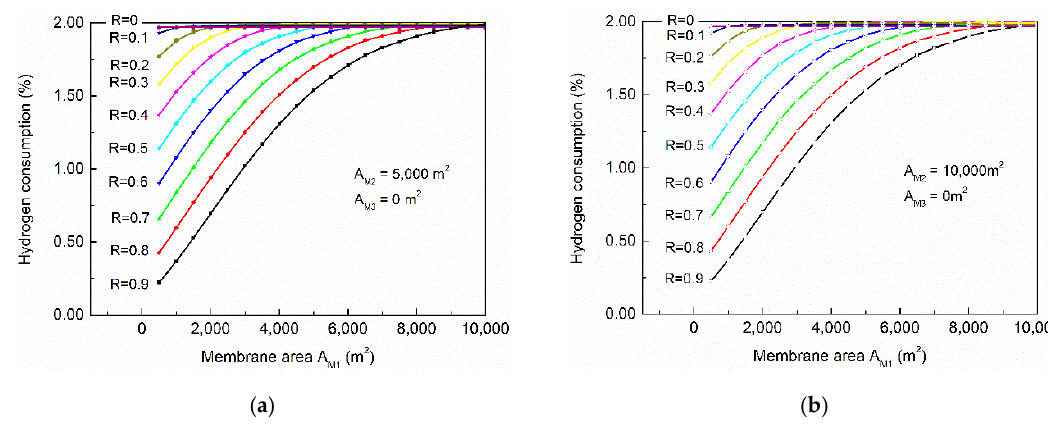
Figure 10. Influences of membrane area on hydrogen consumption. ( a ) Area of membrane-202 was 5000 m 2 ; ( b ) area of membrane-202 was 10,000 m 2 .